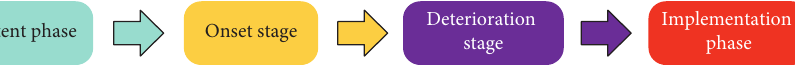
Figure 2: Four stages of